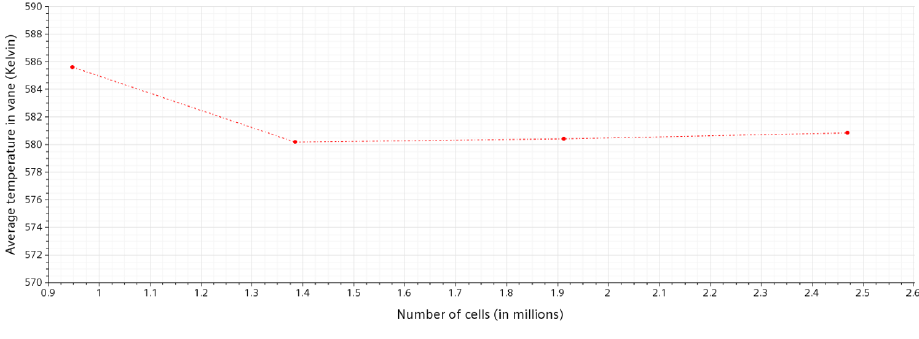
Figure 4. Mesh independence